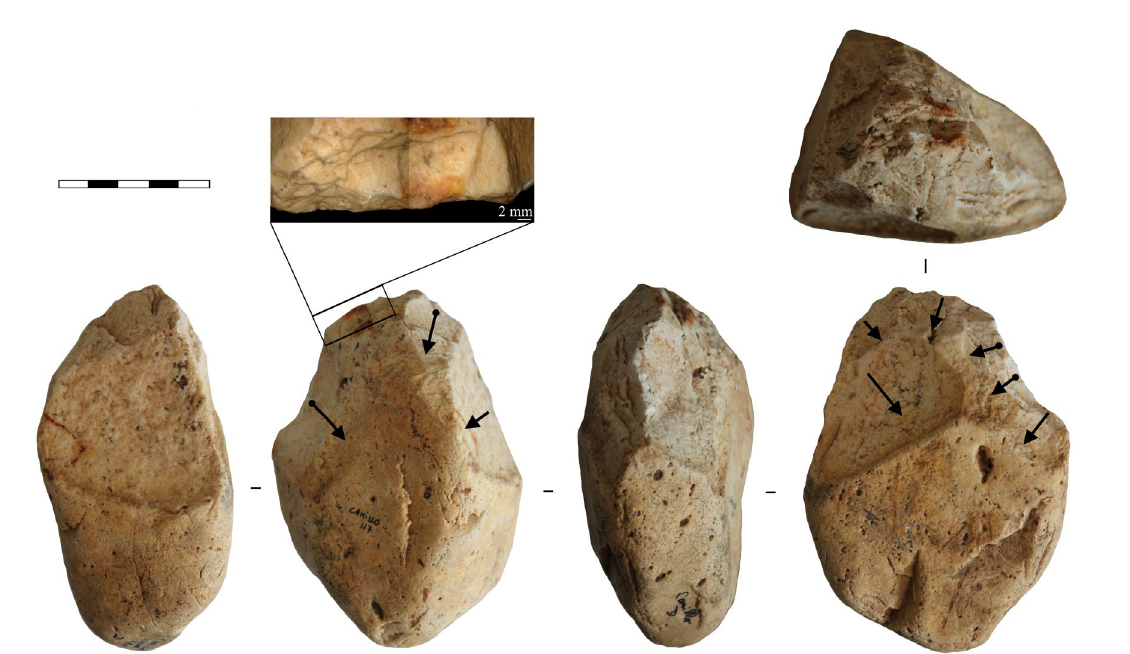
Figure 15. Cobble with bifacial removals in quartzite, with macro-scars on the distal edge. Scale bar (main image): 5